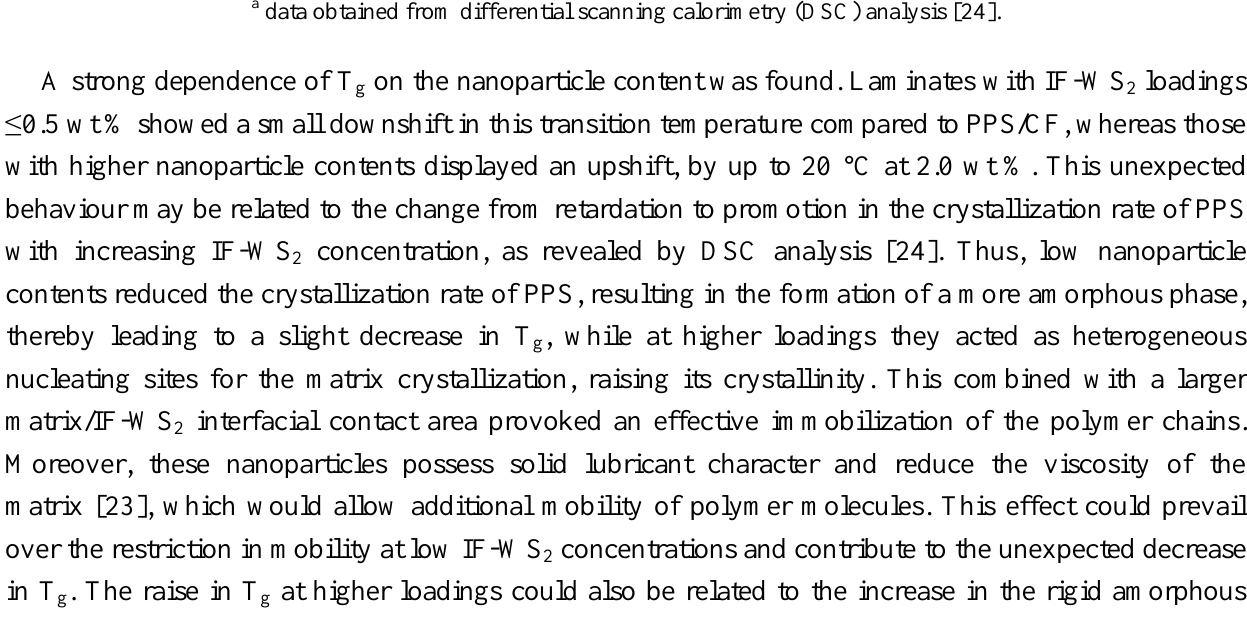
), heat deflection temperature c ) and coefficient of thermal expansion (CTE) of g